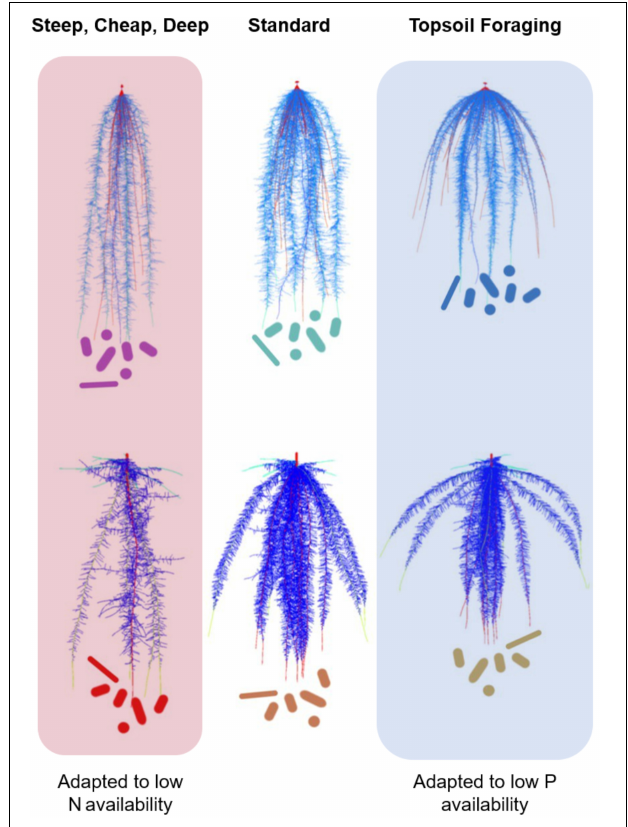
FIGURE 1 | Ideotypes for maize (upper panel) and common beans (lower panel). “ Steep, cheap and deep” root systems with, steep rooting angle, reduced metabolic cost of soil exploration, deep rooting root systems are better adapted to drought and low N availability; while “ Top soil foraging ,” root systems with shallow rooting angle, increased basal root whorl number, and increased lateral root branching have increased tolerance to low P. We propose that different root ideotypes would also have characteristic root microbiomes in the rhizosphere and endosphere, given the different niches offered by each root system. Figure modified from Lynch